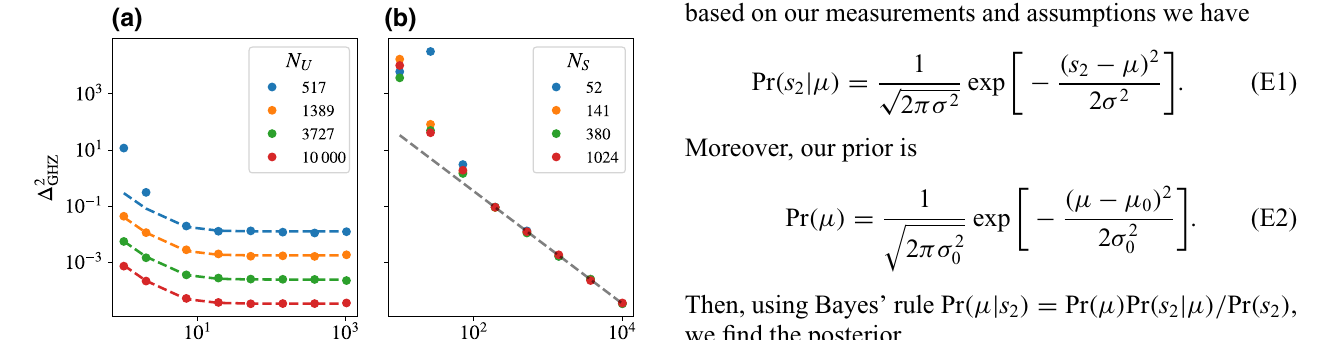
FIG. 5. Scaling of the mean squared error (cid:5) 2 qubit GHZ state for varying (a) N S and (b) N U . The dashed lines indicate the empirical fits (cid:5) 2